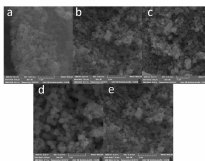
Figure 1. Morphology of samples obtained by SEM, ( a ): TiO 2 , ( b ): TZr-1, ( c ): TZr-3, ( d ): TZr-5, ( e ): TZr-10.